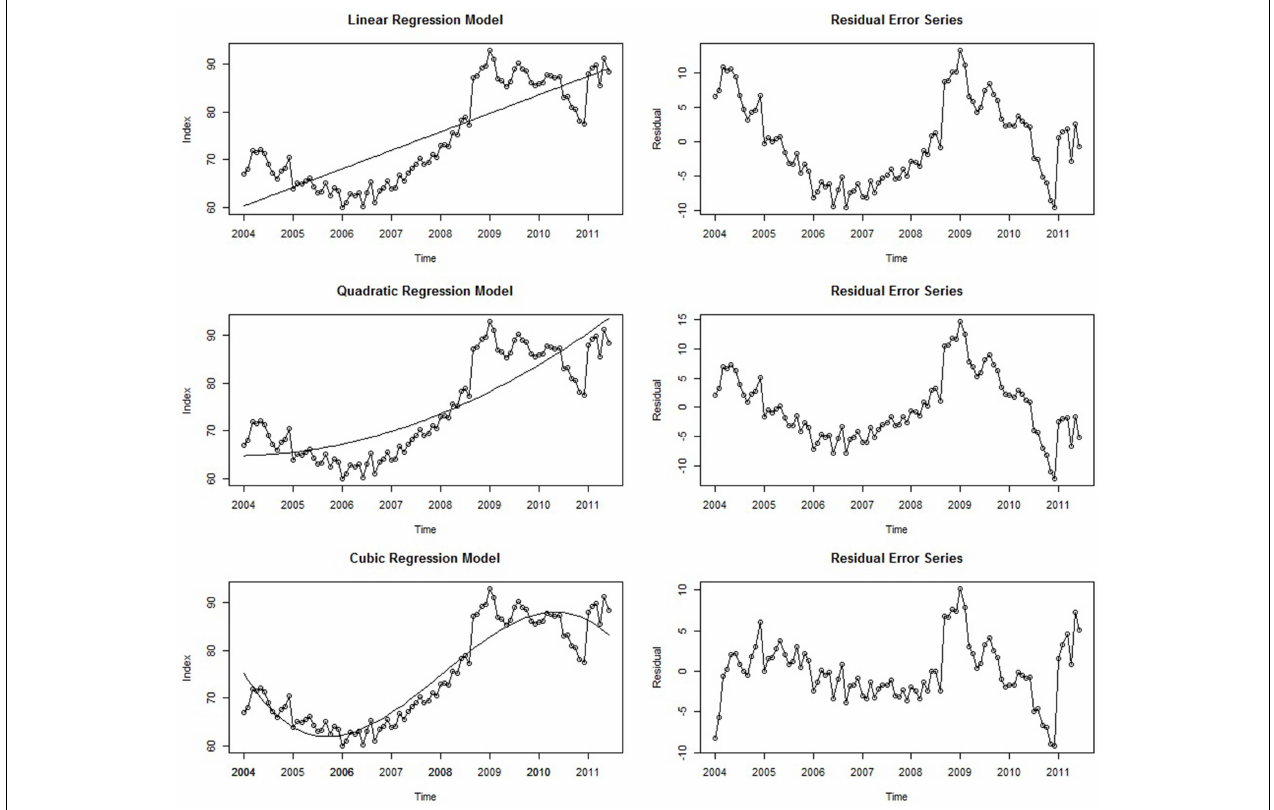
FIGURE 6 | Three different regression models with time as the regressor and their associated residual error